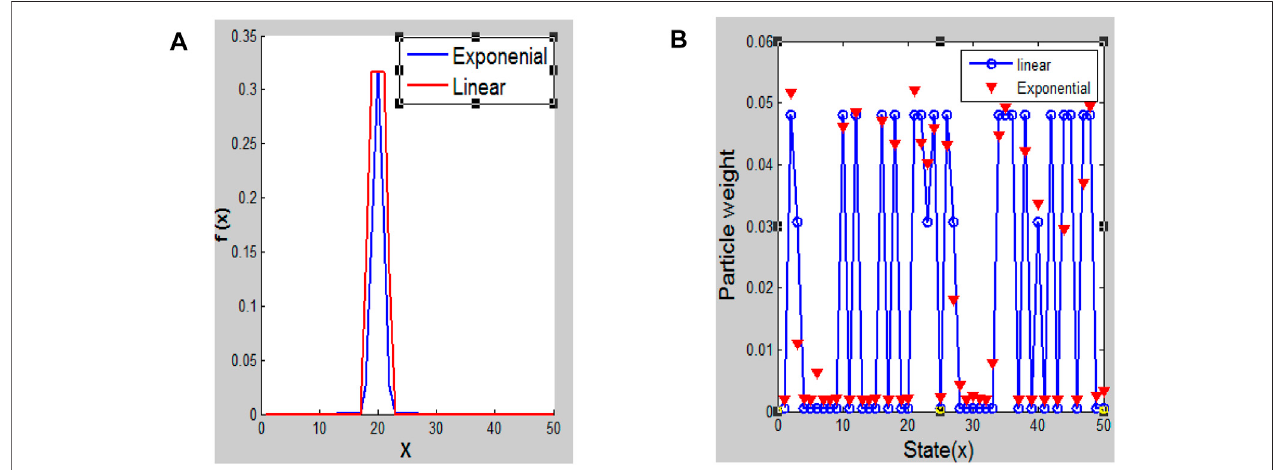
FIGURE 11 | Exponential function (A) MatLab implementation (B) Schematic (C) Simulation.